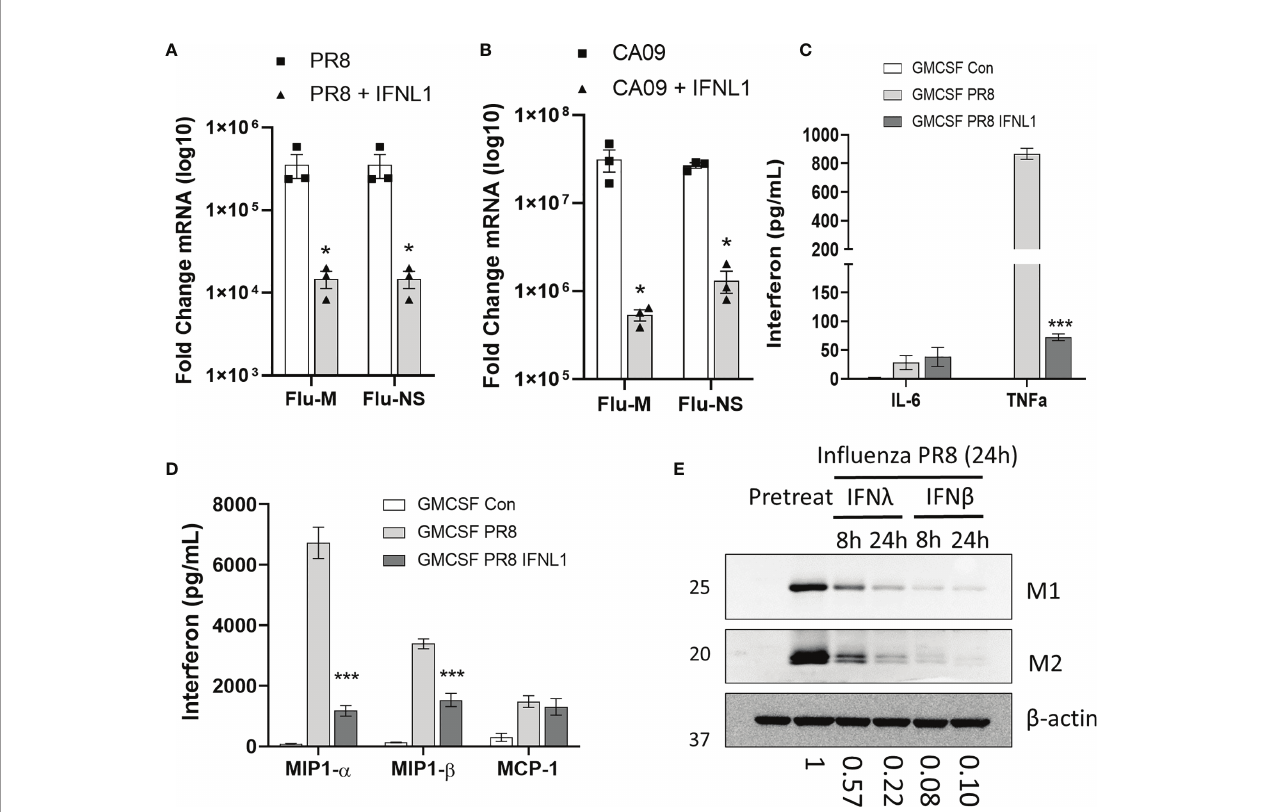
FIGURE 5 | IFN l inhibits macrophage infection. CD14 monocytes were differentiated to macrophages with M-CSF or GM-CSF (50 ng/mL, 7 days). GM-CSF macrophages were pretreated with or without IFNL1 (50 ng/mL) for 24h followed by infection with in fl uenza CA09 (MOI =1) and in fl uenza PR8 (MOI=0.1). Viral replication as determined by measuring the mRNAs of in fl uenza M and NS viral genes by qRT-PCR in PR8 (A) and in CA09 (B) infection. Representative of 3 independent experiments, n= 3 samples per group (A, B) . We examined the production of in fl ammatory cytokines in in fl uenza infected macrophages using a custom multiplex from MSD. n= 2 independent experiment, n= 6 samples per group (C, D) . HAMs were pretreated with IFN L (50 ng/mL) or IFN b (20 ng/mL) for 24 h followed by infection with in fl uenza PR8. Viral protein production was measured by immunoblotting for in fl uenza proteins matrix-1 (M1) and matrix-2 (M2). Below: Matrix 1 protein levels as determined by densitometry of immunoblots. Representative of 3 independent experiments (E). *p < 0.05 by Students T-test (A, B) ***p < 0.001 by Multiple T-test with Holm-Sidak correction (C, D)